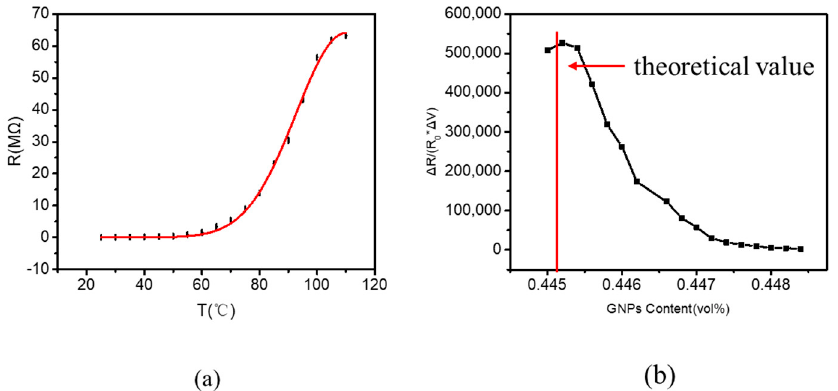
Figure 2. ( a ) Resistance of 1 wt. % GNP/PDMS films at different temperatures. ( b ) Curve between the resistance and the volume concentration of the films varies with temperature.